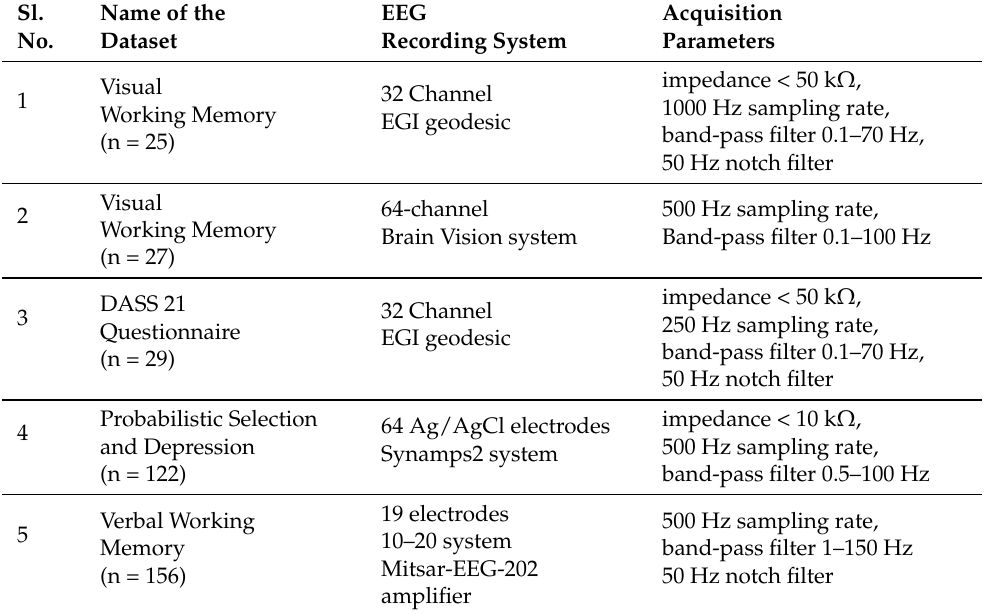
Table 1. Overview of EEG